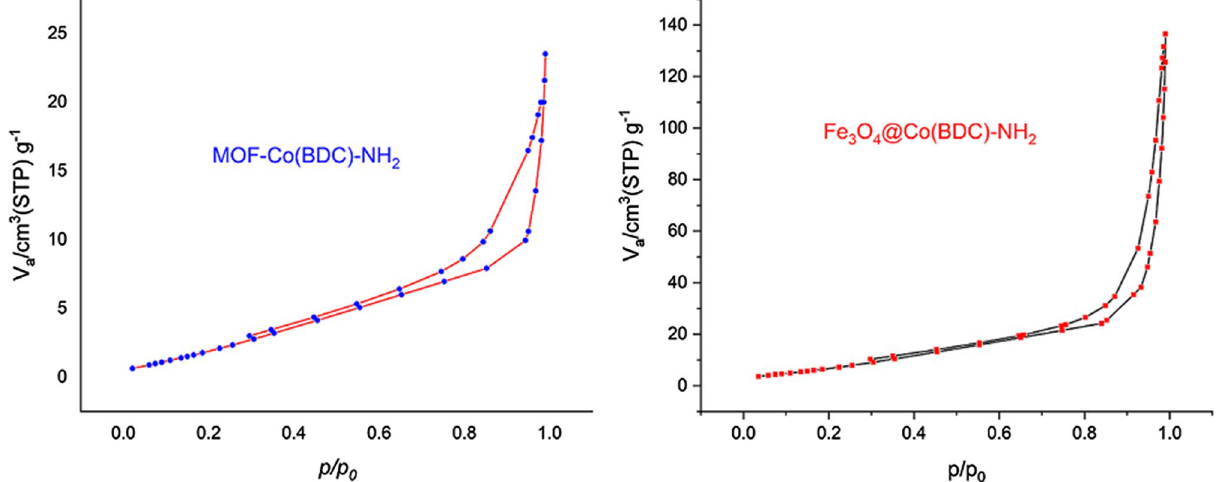
Figure 7. Nitrogen adsorption–desorption isotherm (BET) of Fe 3 O 4 @Co(BDC)-NH 2 and MOF- Co(BDC)-NH 2